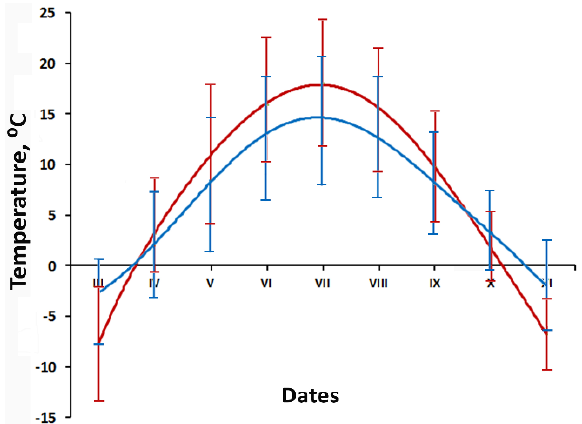
Figure 4. Average monthly air temperature at Duvan, Russia (~35 km from Arkaulovskoye Mire), 1966–2017 (red curve) and at Darn/Hamra, Sweden (~12 km from Nätsjöbäcken Mire), 2002– 2018 (the flatter blue curve). Both mires have populations of Schoenus ferrugineus